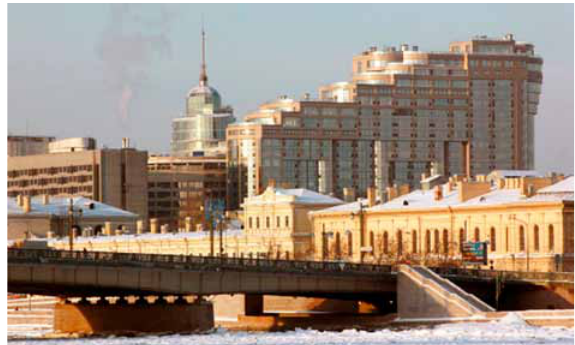
fig. 4. “Mont Blanc” building distort the historical panorama of the neva river (Shishkin 2012)